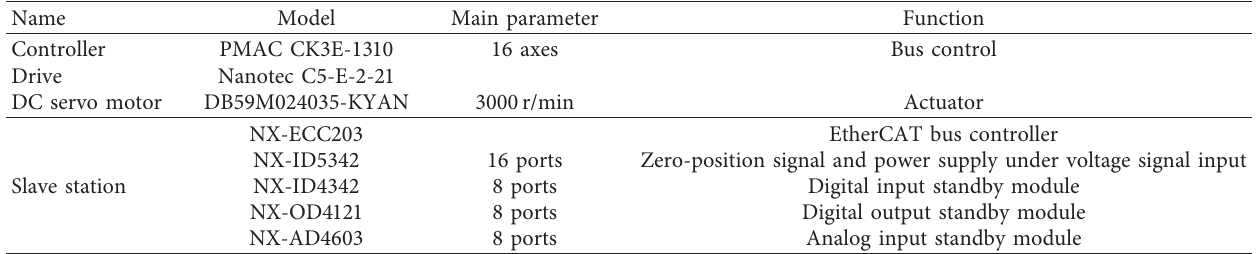
Figure 20: Experimental platform. (a) Single-leg system. (b) Main electrical components. (c) Measurement system. Table 3: Main electrical